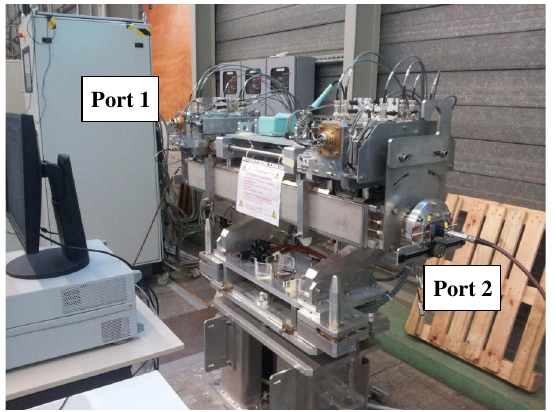
FIG. 7. The TCT collimator used during the rf impedance measurements campaign. Ports 1 and 2 are the VNA ports used for the reflection and transmission measurements.